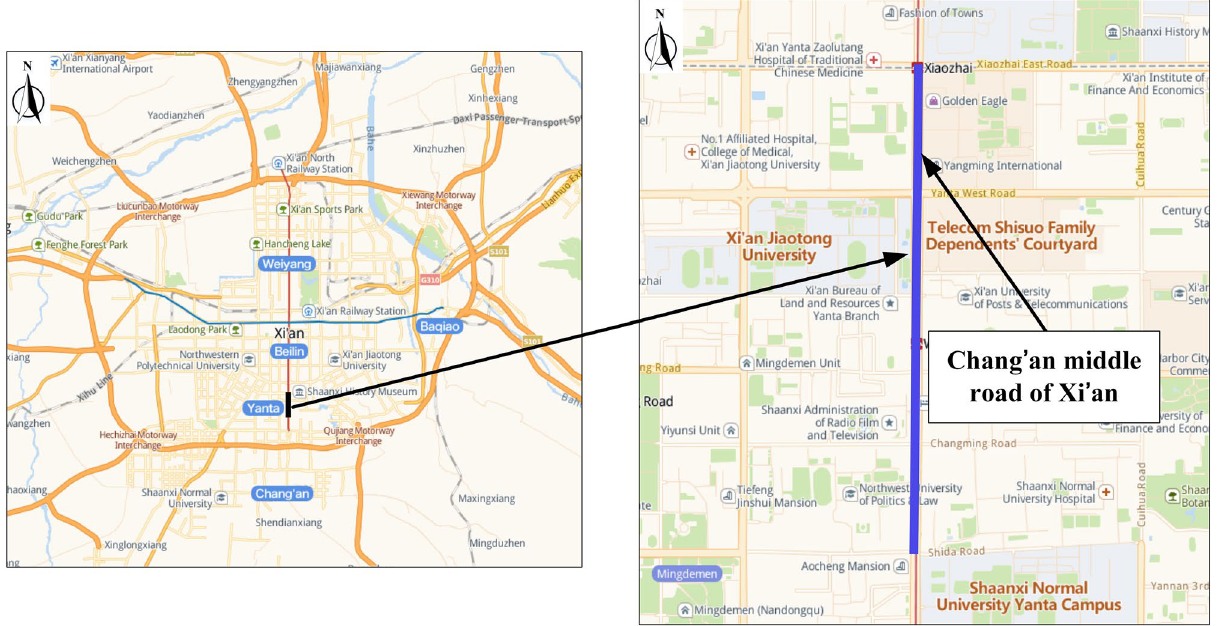
Figure 1. Location of experimental path and its details. And figure was plotted by Microsoft Office Visio 2013, which can be downloaded on https:// www. micro soft.